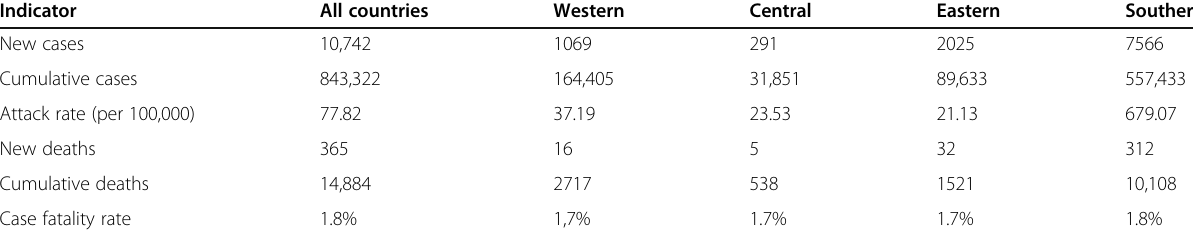
Table 3 COVID-19 core indicators for SSA countries, by region (to August 8, 2020) [45] Indicator